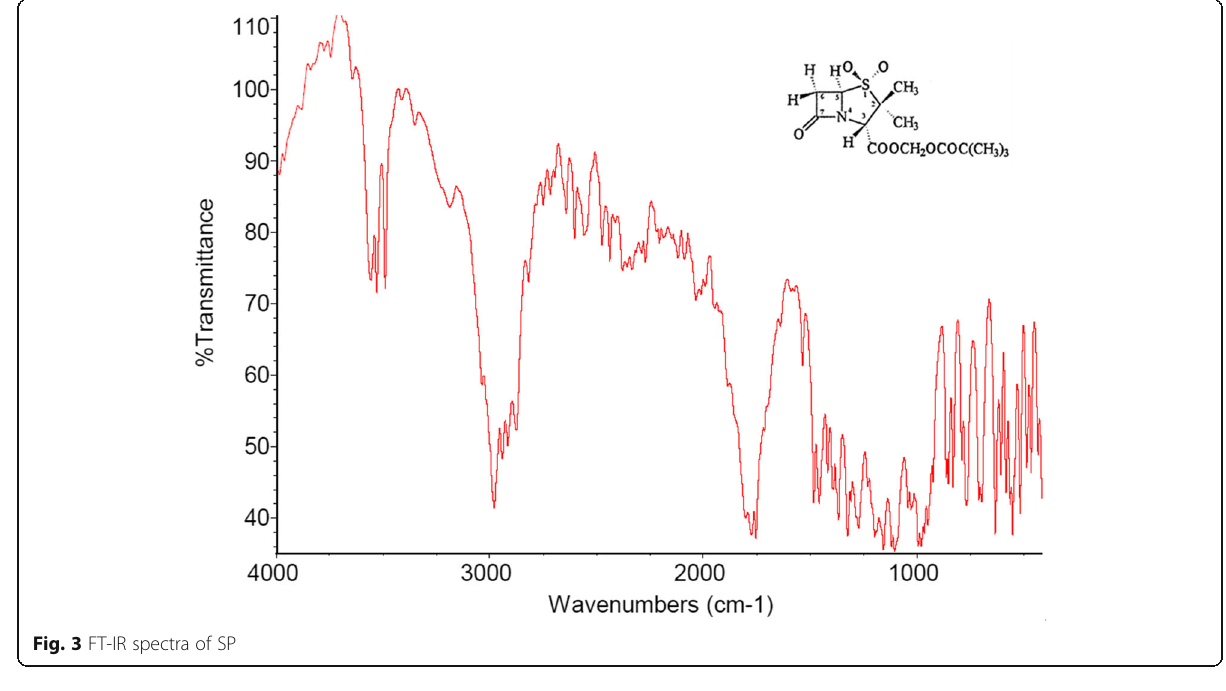
Fig. 3 FT-IR spectra of SP